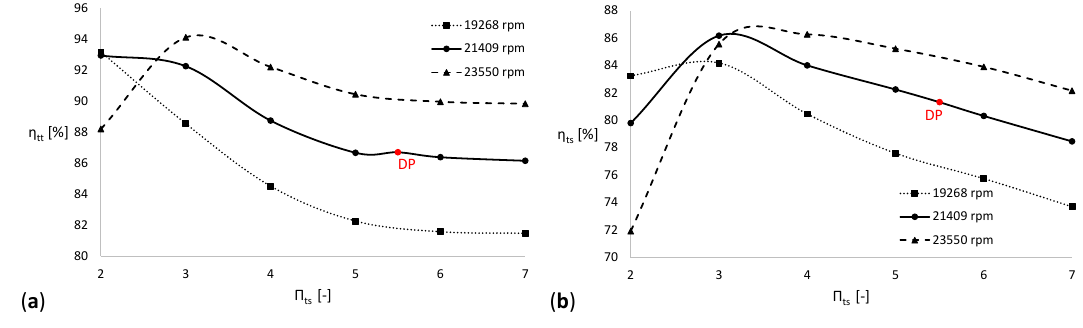
Figure 11. Variation of efficiencies with total-to-static pressure ratio at three rotational speeds: ( a ) Total-to-total efficiency, ( b ) Total-to-static efficiency.